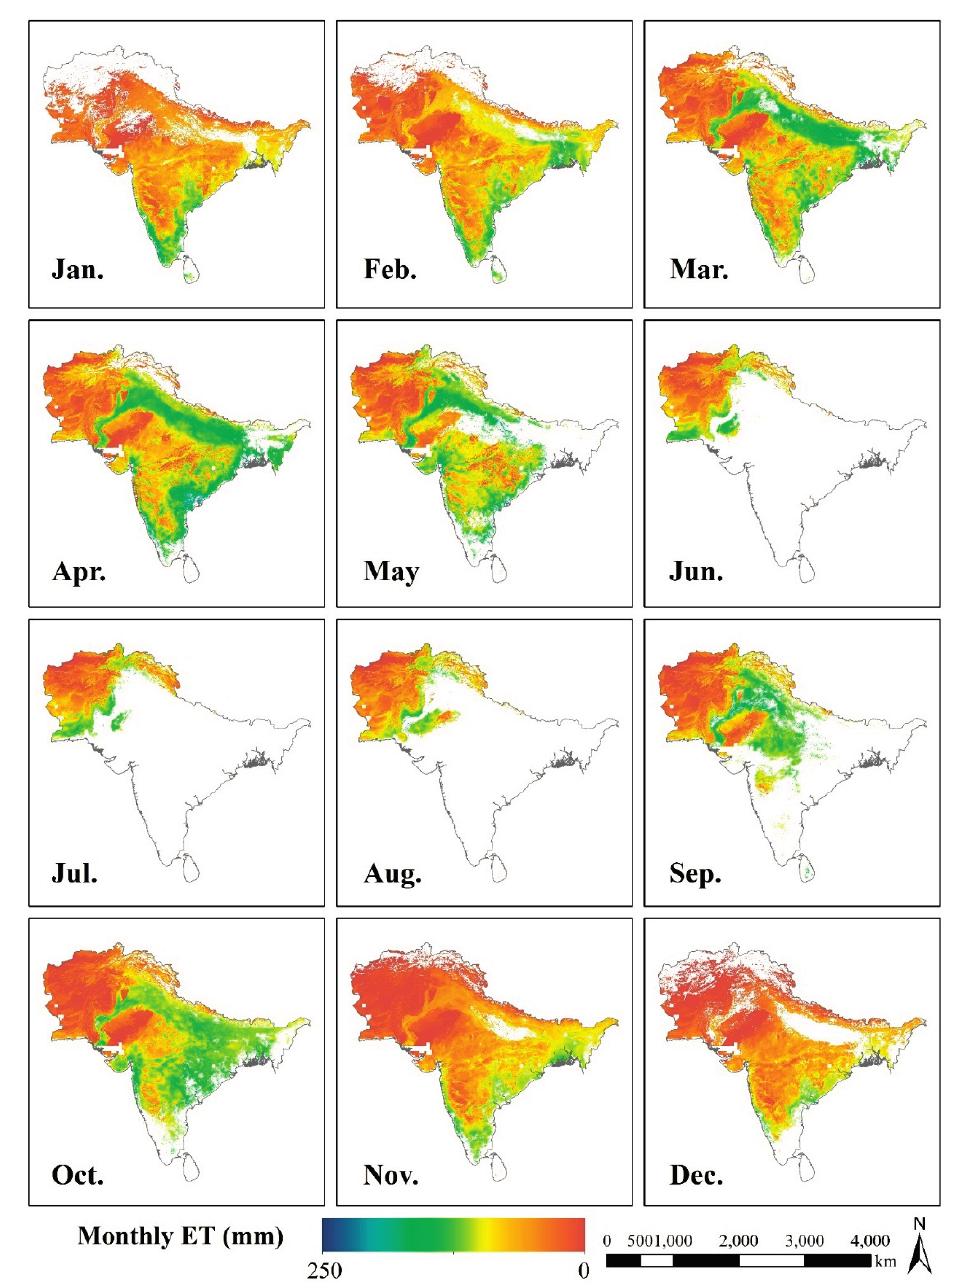
Figure 4. Monthly ET estimation results in South Asia in